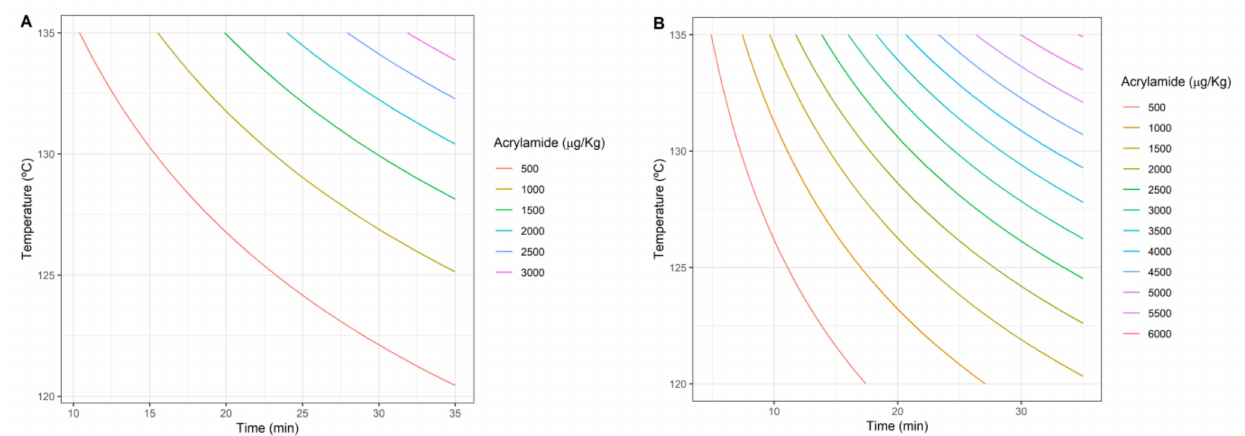
Figure 2. Amount of acrylamide formed as a function of heat treatment (time, temperature) for the potato puree ( A ) and prune juice ( B ).